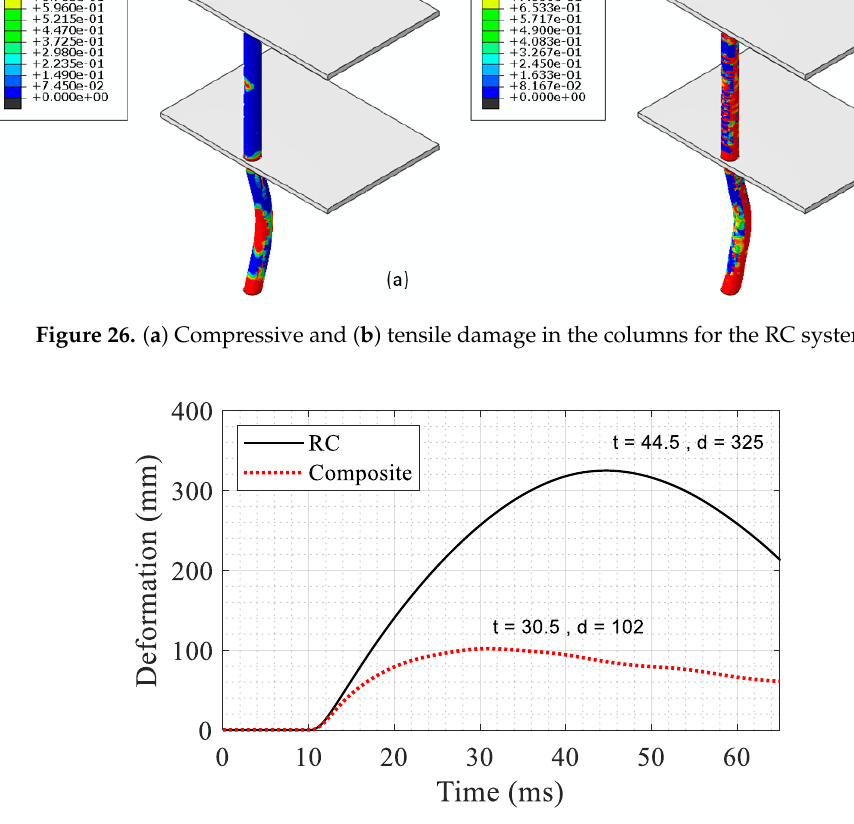
Figure 27. Comparison of deformation time history at mid-height of the first floor ( t is time in ms and d is deformation in mm).